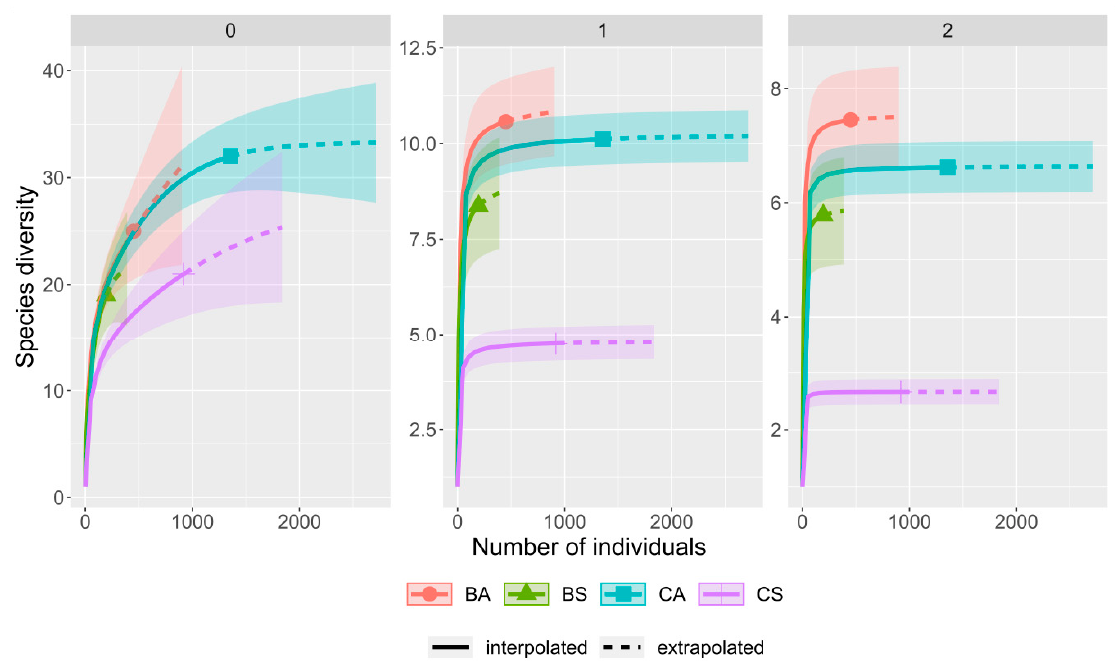
Figure 5. Accumulation curves of the Hill numbers of the collembolan assemblages in control and bioturbated plots. BS, bioturbation plots—spring; CS, control plots—spring; BA, bioturbation plots—autumn; CA, control plots—autumn. 0, 0 D species richness; 1, 1 D exponential Shannon’s entropy index; 2, 2 D inverse Simpson’s index.